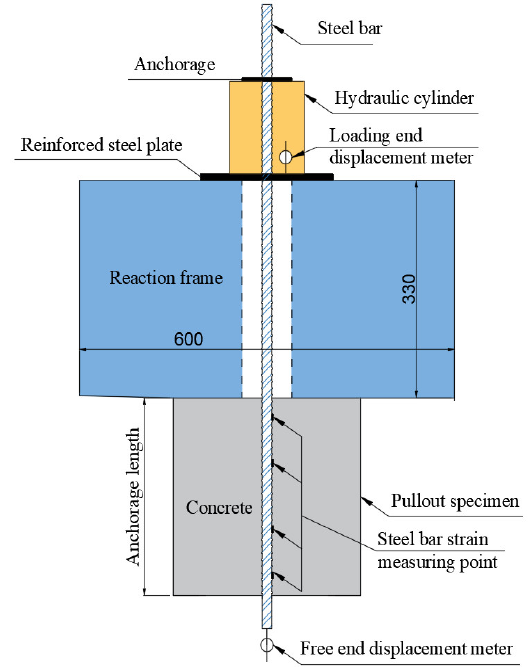
Figure 2. Schematic diagram of the loading device.